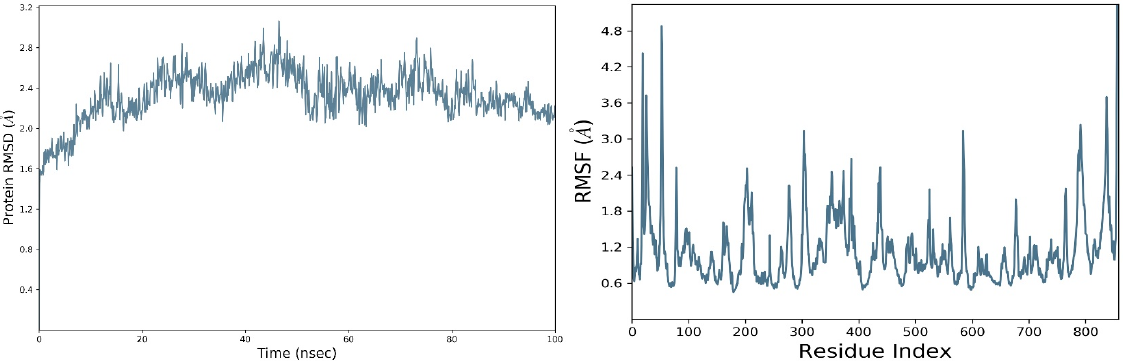
Figure 2. The root mean square deviation ( Left panel ), and root means square fluctuation ( Right panel ) of the amino acid residues of RdRp apo-enzyme of SARS-CoV-2.